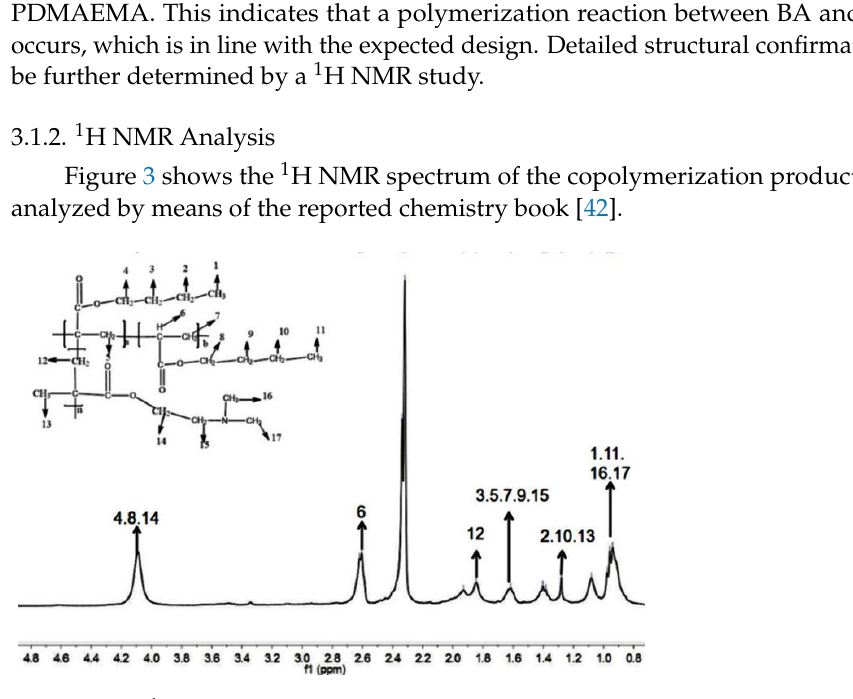
Table 2. Molecular weights of PBA-g-PDMAEMA. Sample